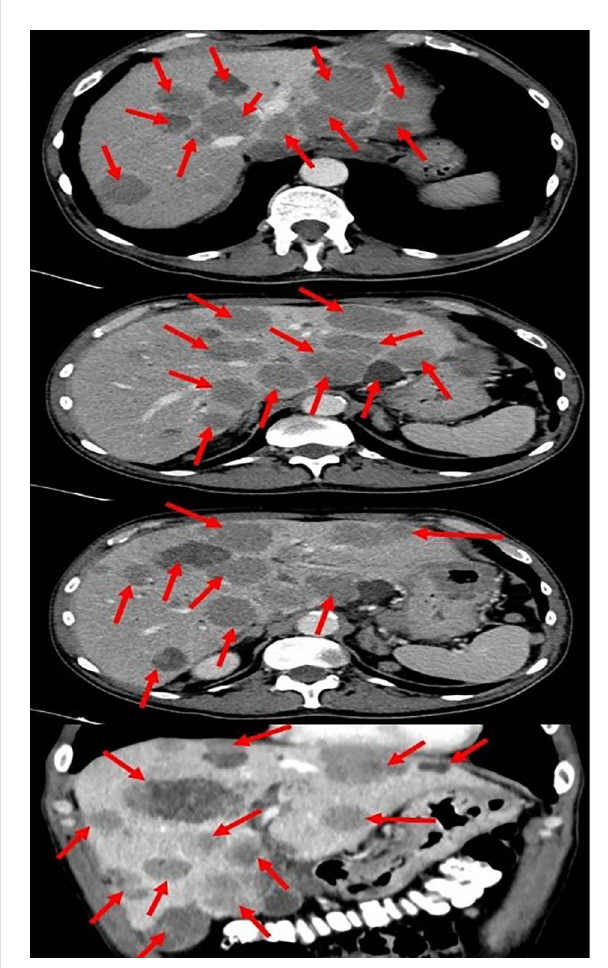
FIGURE 1 Total body computed tomography scan showing the metastatic melanoma in the liver (red